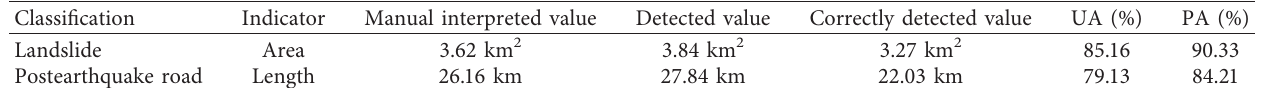
Figure 8: Road pavement damage cases. (a) Partially destroyed pavement with rocks caused by adjacent landslide. (b) Totally destroyed pavement buried by landslide. Table 4: Accuracy assessment of landslide and postearthquake road.